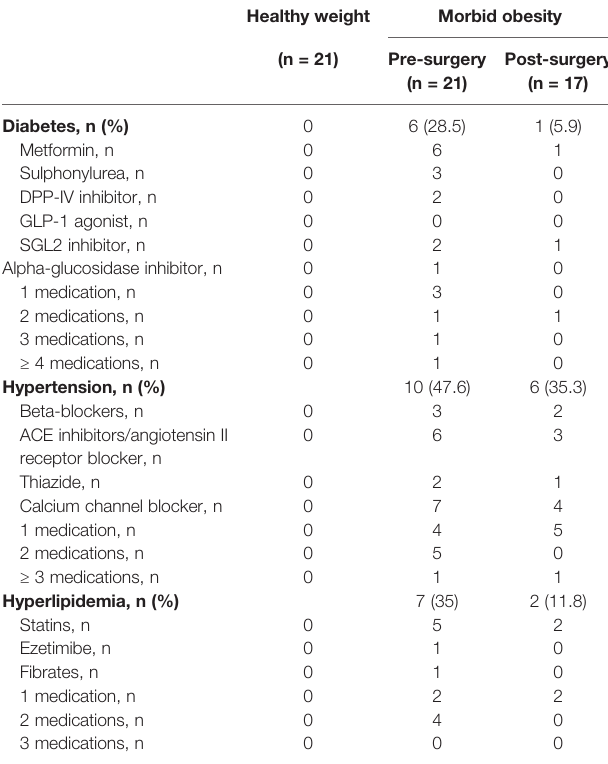
TABLE 2 | Metabolic co-morbidities and medications in participants with healthy weight and with morbid obesity. Healthy weight